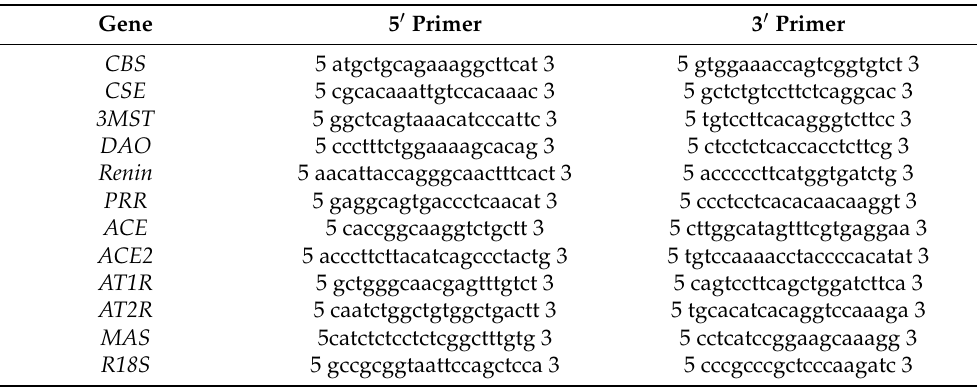
Table 1. Primer sequences for quantitative real-time